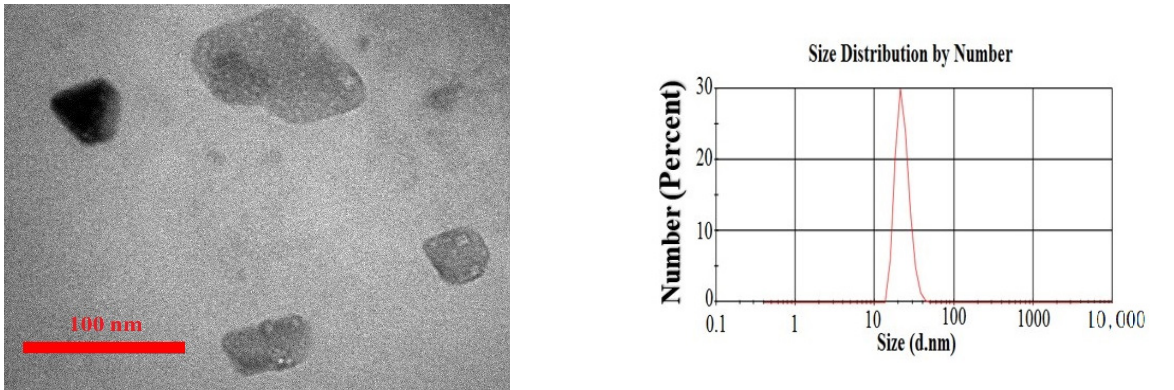
Figure 1. TEM image of sonochemical synthesis of CeO 2 -SA nanoparticles ( left ), and DLS analysis of CeO 2 -SA nanoparticles ( right ).